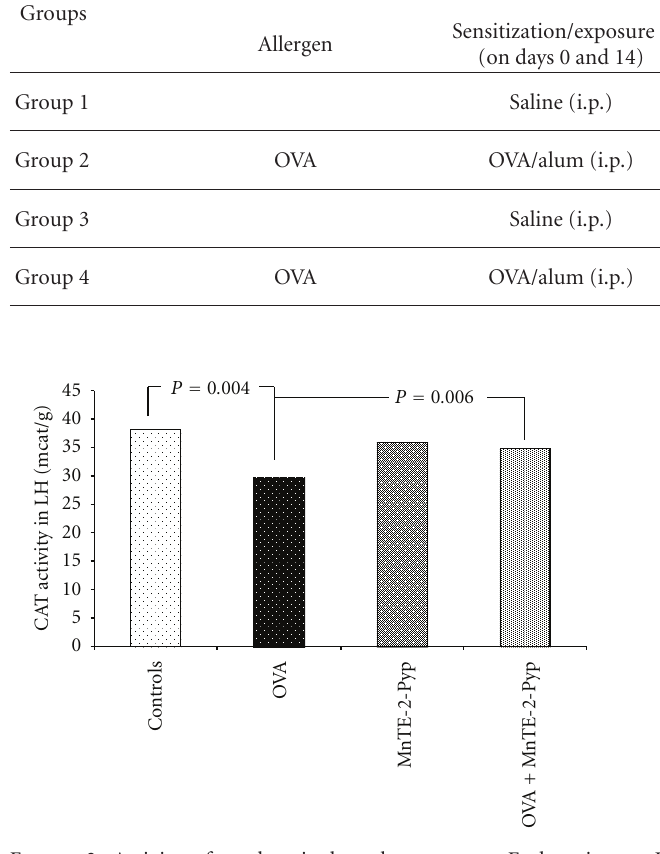
Figure 3: Activity of glutathione peroxidase in lung homogenate. Each point represents the median for six